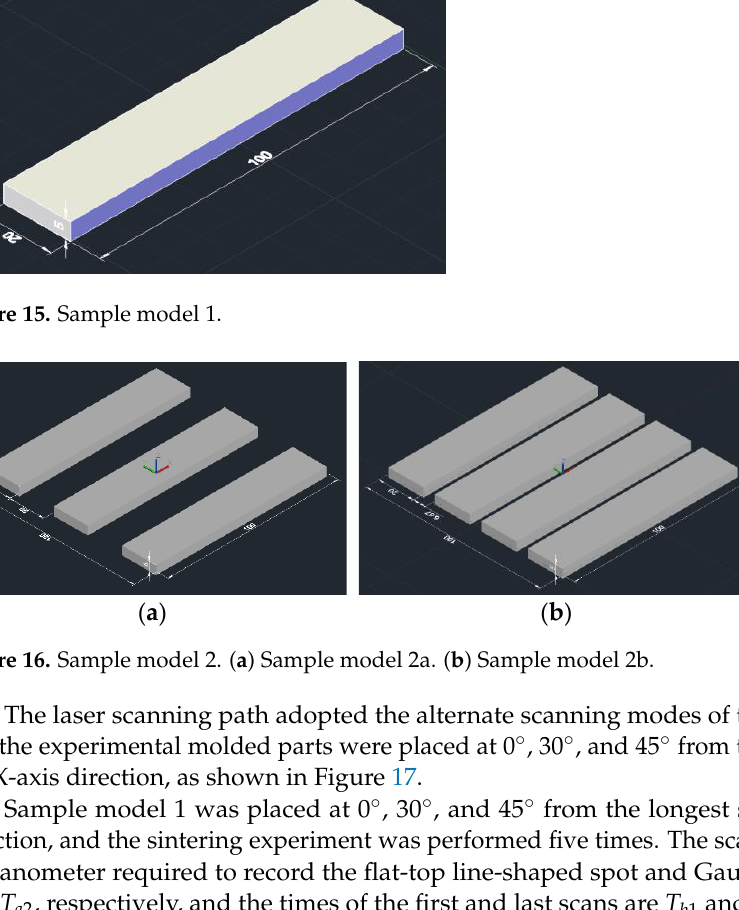
( b ) Figure 17. Placement of sample model 1. ( a ) Horizontal placement. ( b ) Sideways placement.